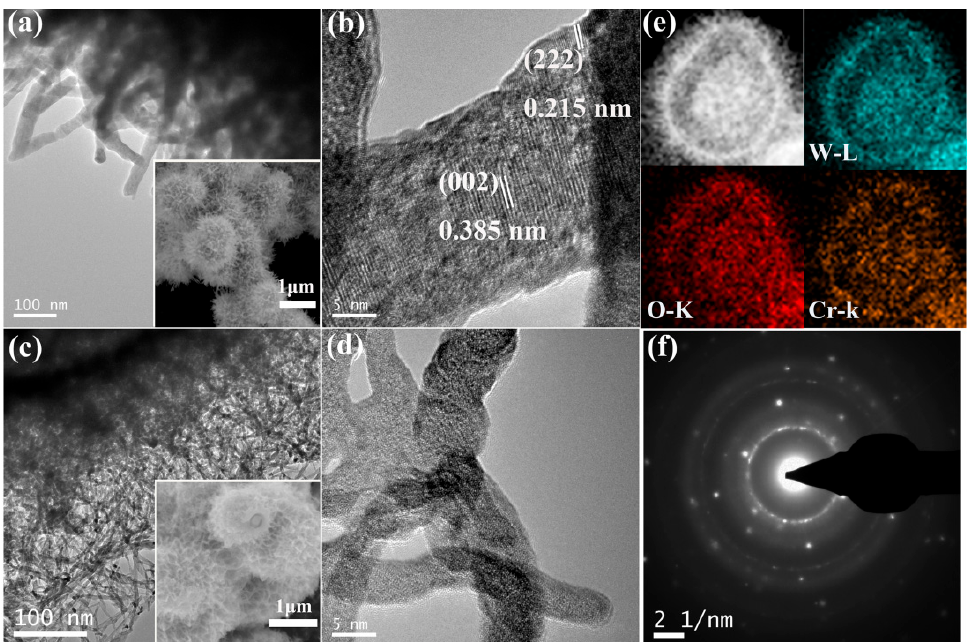
Figure 5. ( a ) TEM ( b ) high-resolution transmission electron microscopy (HR-TEM) images of W Cr-0mg ; ( c ) TEM ( d ) HRTEM images of W Cr-100mg ; (The inset images of a and c are the SEM images of W Cr-0mg and W Cr-100mg , respectively.) ( e ) Elemental mapping for W, O, and Cr elements in W Cr-100mg ; ( f ) selected area electron diffraction (SAED) pattern of W Cr-100mg.